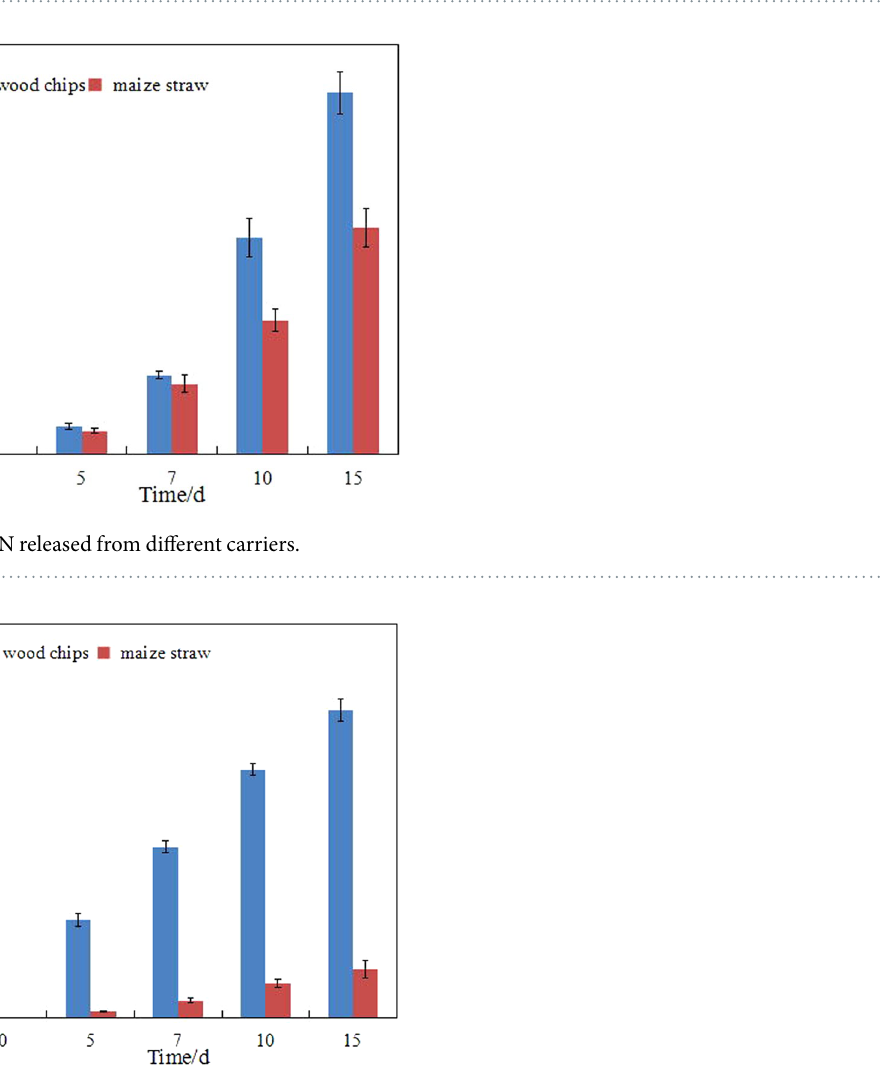
Figure 4. The concentration of dehydrogenase.